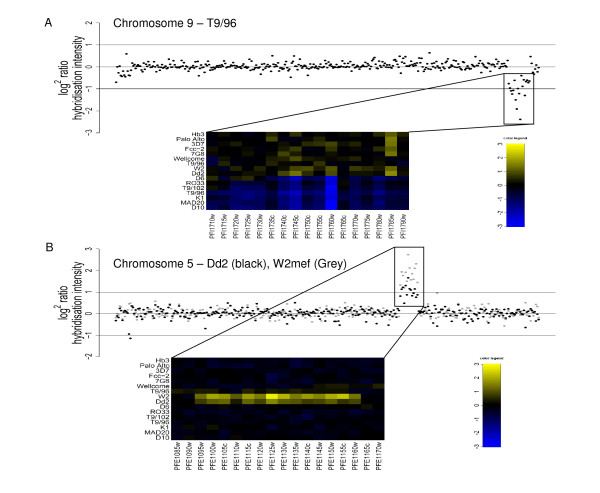
CNV regions in the P. falciparum genome. Detection of previously described multi-genic deletions and amplifications. Plots show log2 hybridisation signal of individual genes in physical order along chromosomal length with cut-offs for amplification/deletion of a gene shown by lines at 1/-1 respectively. Heatmaps show CNV regions at greater resolution for all hybridised strains with genes amplified or deleted as indicated by the colour key (yellow and blue respectively). A. Multi-genic deletion on chromosome 9. B. Multi-genic amplification on chromosome 5.